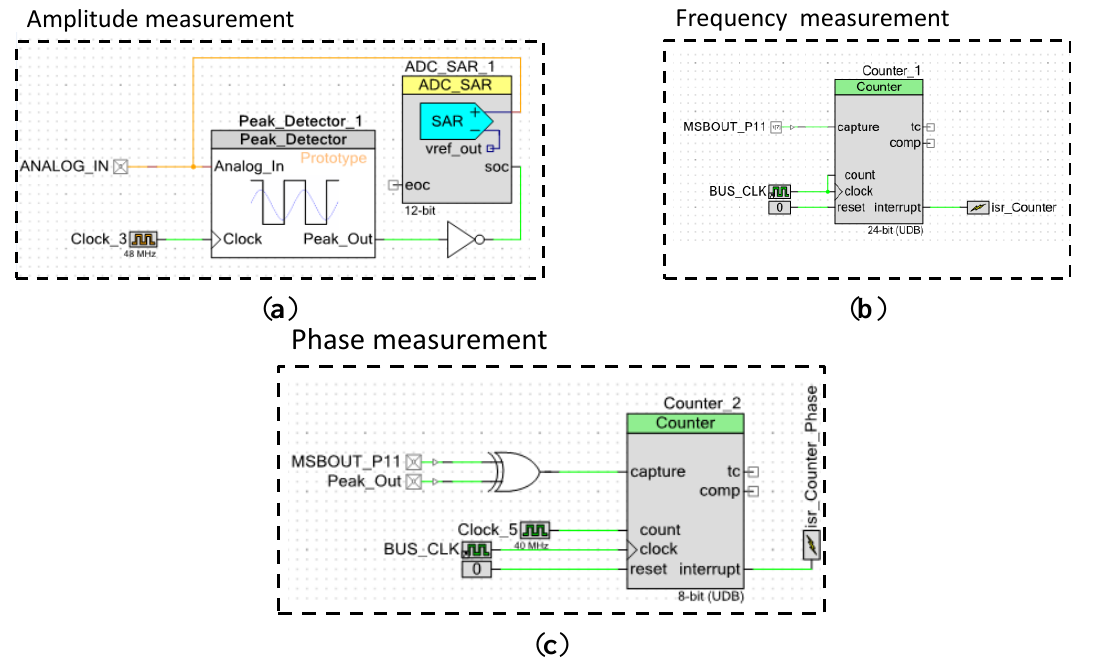
Figure 15. ( a ) Amplitude measurement stage: the peak detector output triggers the ADC acquisition. ( b ) Frequency measurement feedback stage measures the period of the MSB OUT signal that is generated by the AD5932. It allows a period precision control of 0.66 ns. ( c ) Phase calculation using XOR gate. The minimum measurable ΔT between the excitation signal and the measured one is equal to 0.25 ns.